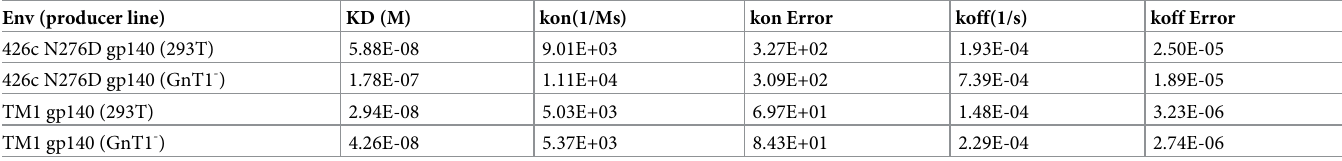
Table 5. Germline-reverted VRC01 Fab binding to 426c Env variants produced in 293T and GnT1 - cells. Env (producer